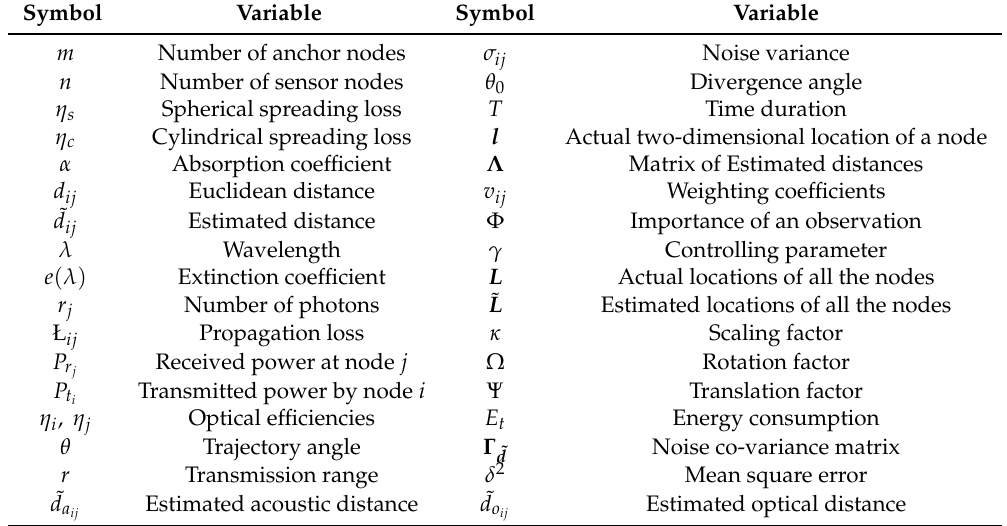
Table 2. List of